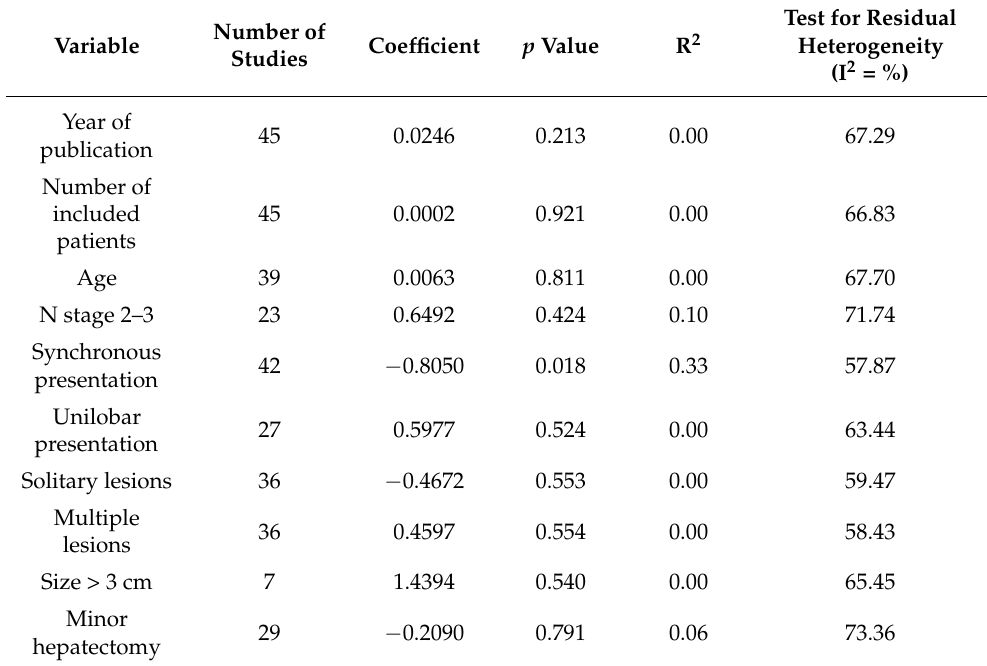
Table 5. Meta-regression of prognostic